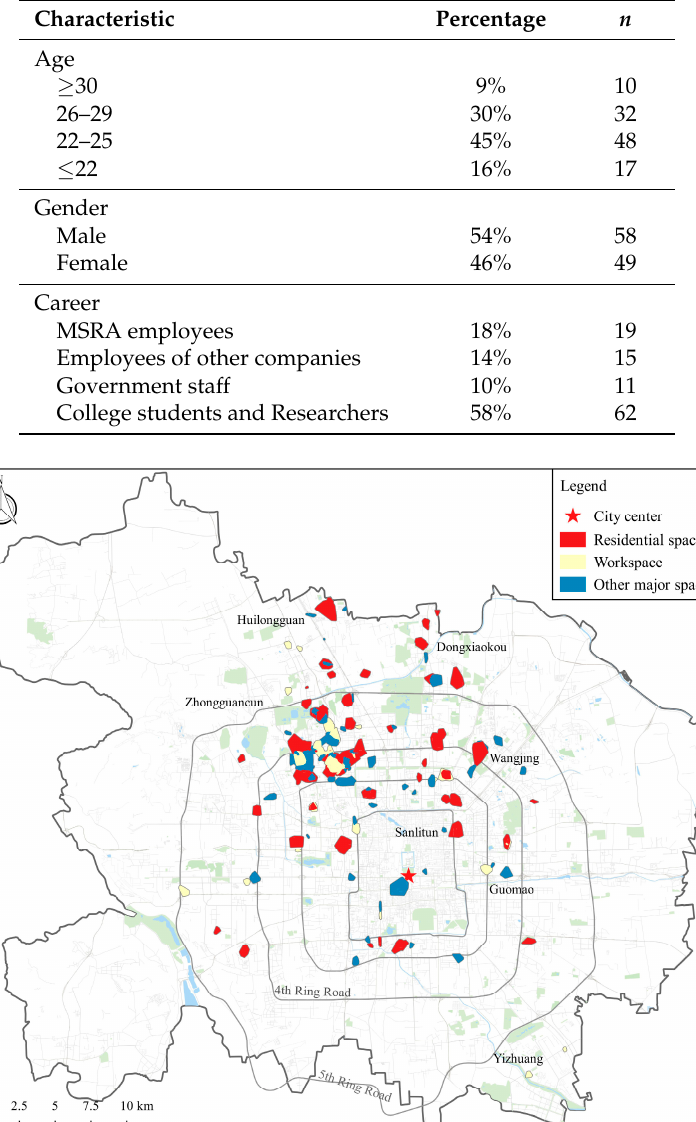
Table 1. Descriptive statistics of sample characteristics ( n = 107).